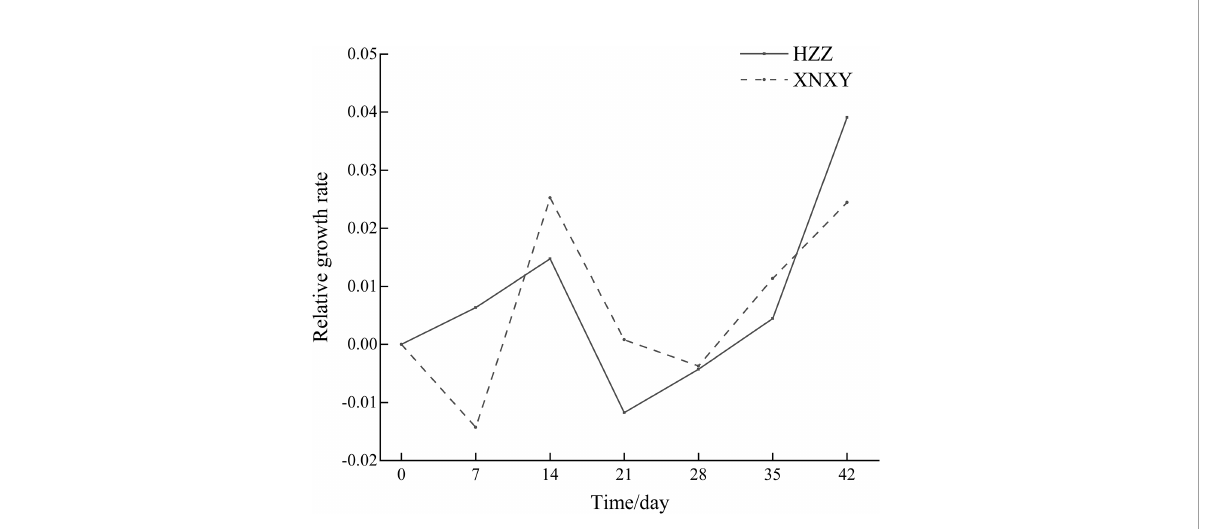
FIGURE 1 Absolute growth rate of shoots of ‘ Xiangnong Xiangyun ’ and ‘ Hei Zhenzhu ’ during low temperature culture. ‘ XNXY ’ stands for ‘ Xiangnong Xiangyun ’ , ‘ HZZ ’ stands for ‘ Hei Zhenzhu ’ .